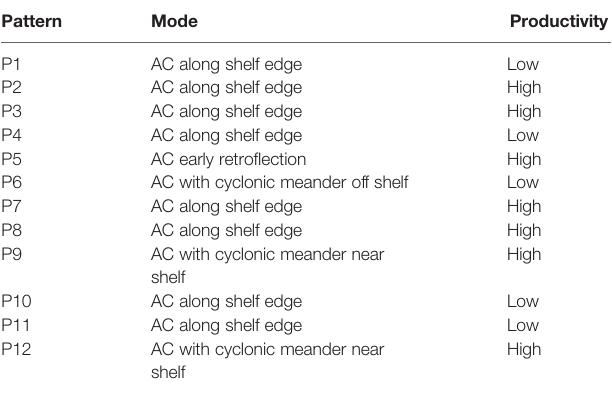
TABLE 2 | Summary of the SOM current patterns classi fi cation and their associated productivity state.